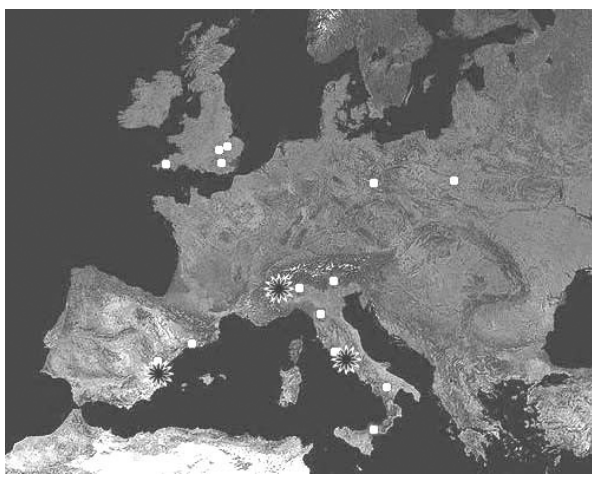
Figure 1. Geographical position of ESR sites in the European re- gion (white dots) and of the stations used in this work (black